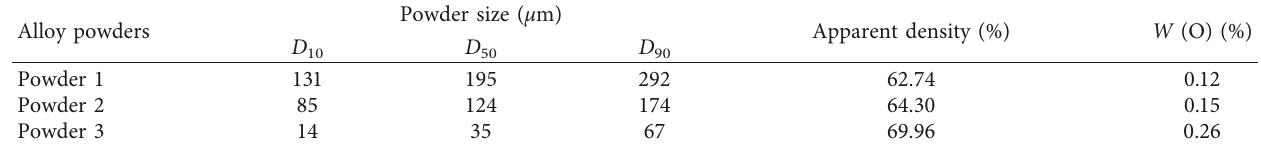
Table 1: Basic characteristics of the powder.